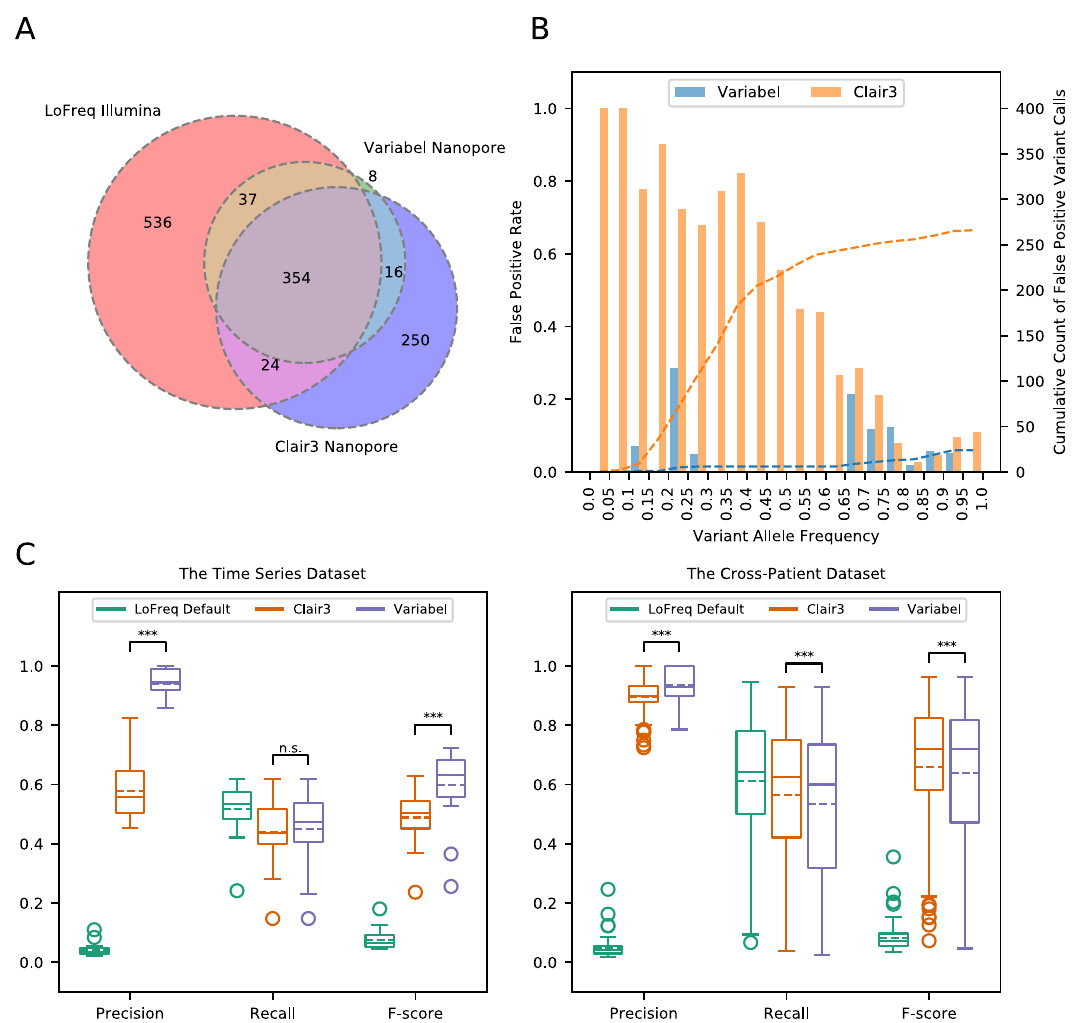
Fig. 3 Intra-host variant detection on COVID-19 datasets. A Venn diagram showing counts of variant calls shared between LoFreq on Illumina sequencing runs and Variabel and Clair3 on nanopore sequencing runs on the same samples from the time series dataset. B False positive rates at different variant allele frequencies and cumulative count of false positive variant calls of Variabel and Clair3 for the time series dataset. C Precision, recall, and F-score comparison of LoFreq default, Clair3, and Variabel on both the time series dataset ( n = 18 samples from the same COVID-19-positive patient collected over distinct time points) and the cross-patient dataset ( n = 103 biologically independent samples collected from COVID-19-positive patients). Each box plot includes both median line (solid) and mean line (dashed), and the box bounds the interquartile range (IQR). The Tukey-style whiskers extend from the box by at most 1.5 × IQR. The circle denotes outliers that extend beyond the whiskers. Signi fi cance between Clair3 and Variabel were calculated using the two- sided paired t -test. Signi fi cance labeling: n.s.( P > 0.05), *( P ≤ 0.05), **( P ≤ 0.01), ***( P ≤ 0.001). The exact p -values of the two-sided paired t -test of precision, recall, and F-score between Clair3, and Variabel for the time series dataset are 3.36 × 10 − 11 , 0.479, and 9.26 × 10 − 7 . The exact p -values of the two-sided paired t -test of precision, recall, and F-score between Clair3, and Variabel for the cross-patient dataset are 1.63 × 10 − 8 , 3.86 × 10 − 9 ,